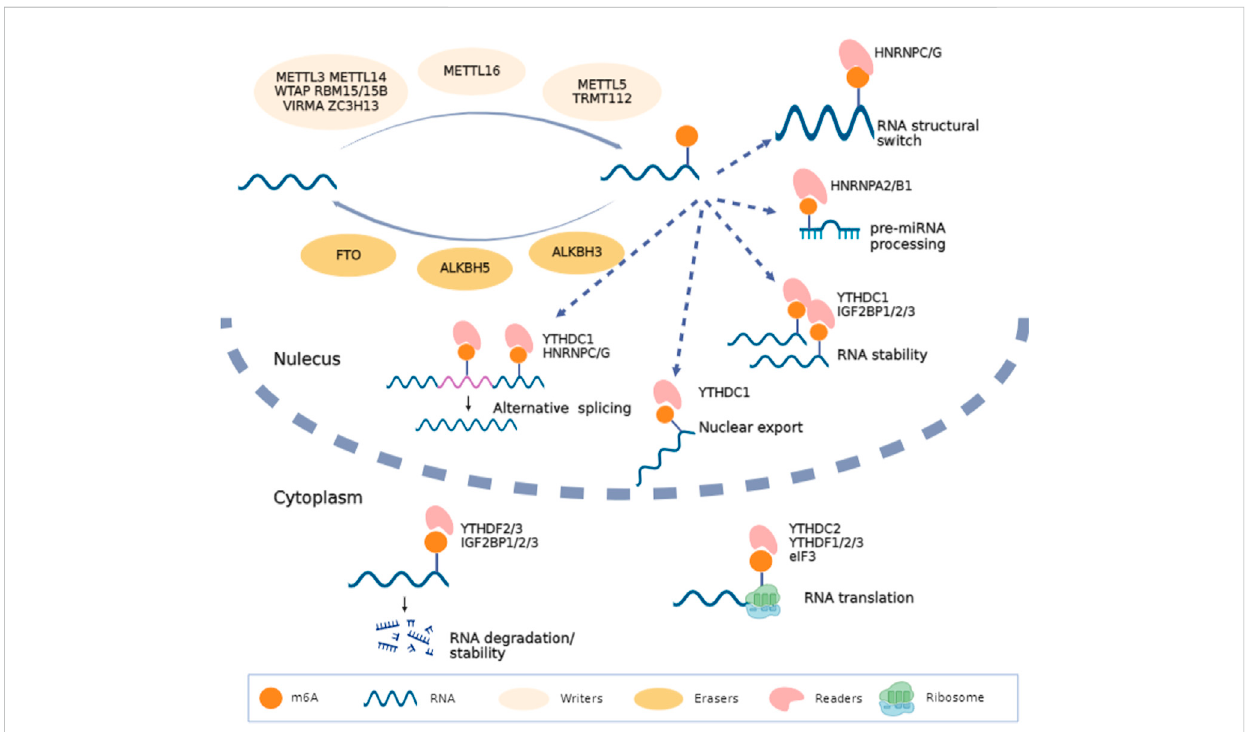
FIGURE 1 Biofunctions of m 6 A in RNA metabolism. RNA m 6 A is methylated under the action of methyltransferases (METTL3, WTAP, METTL14, RBM15/15B, VIRMA, ZC3H13, METTL16, METTL5 and TRMT112), demethylated mediated by demethylases (FTO, ALKBH5 and ALKBH3) and recognized by binding proteins (YTHDC1/2, YTHDF1/2/3, IGF2BP1/2/3, HNRNP and eIF3). This fi gure was drawn using BioRender